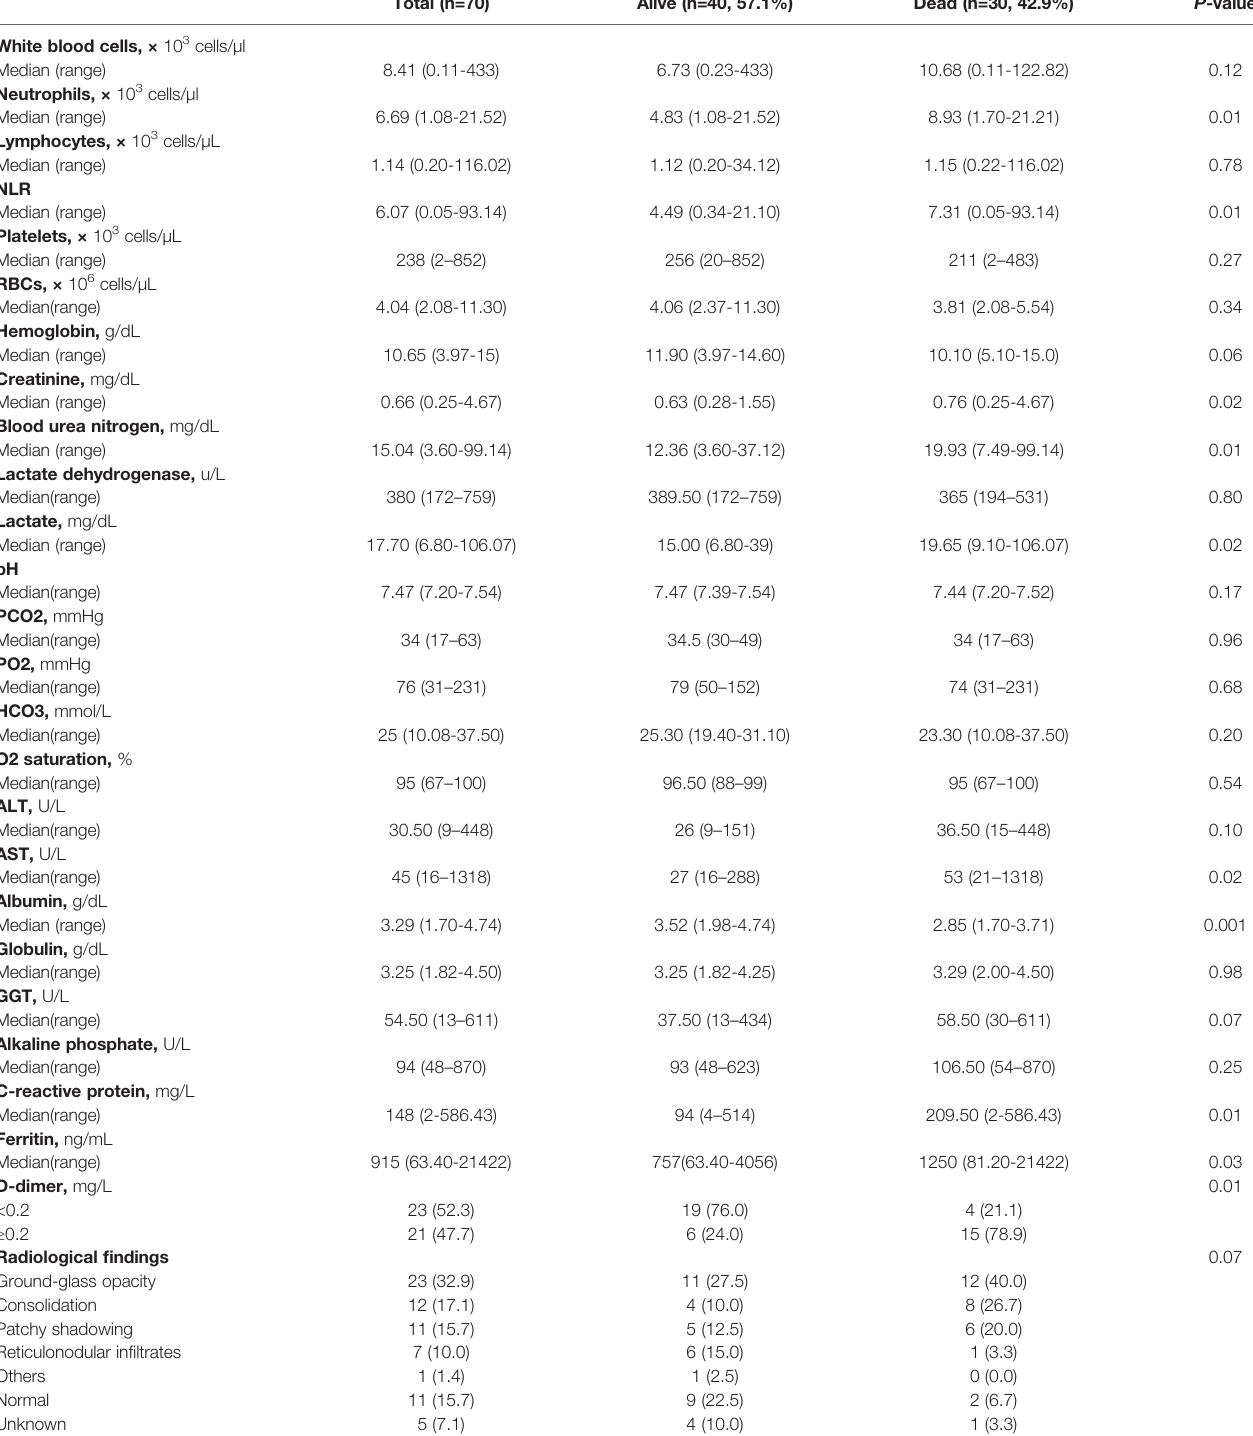
TABLE 2 | Laboratory and Radiological fi ndings of patients with cancer and